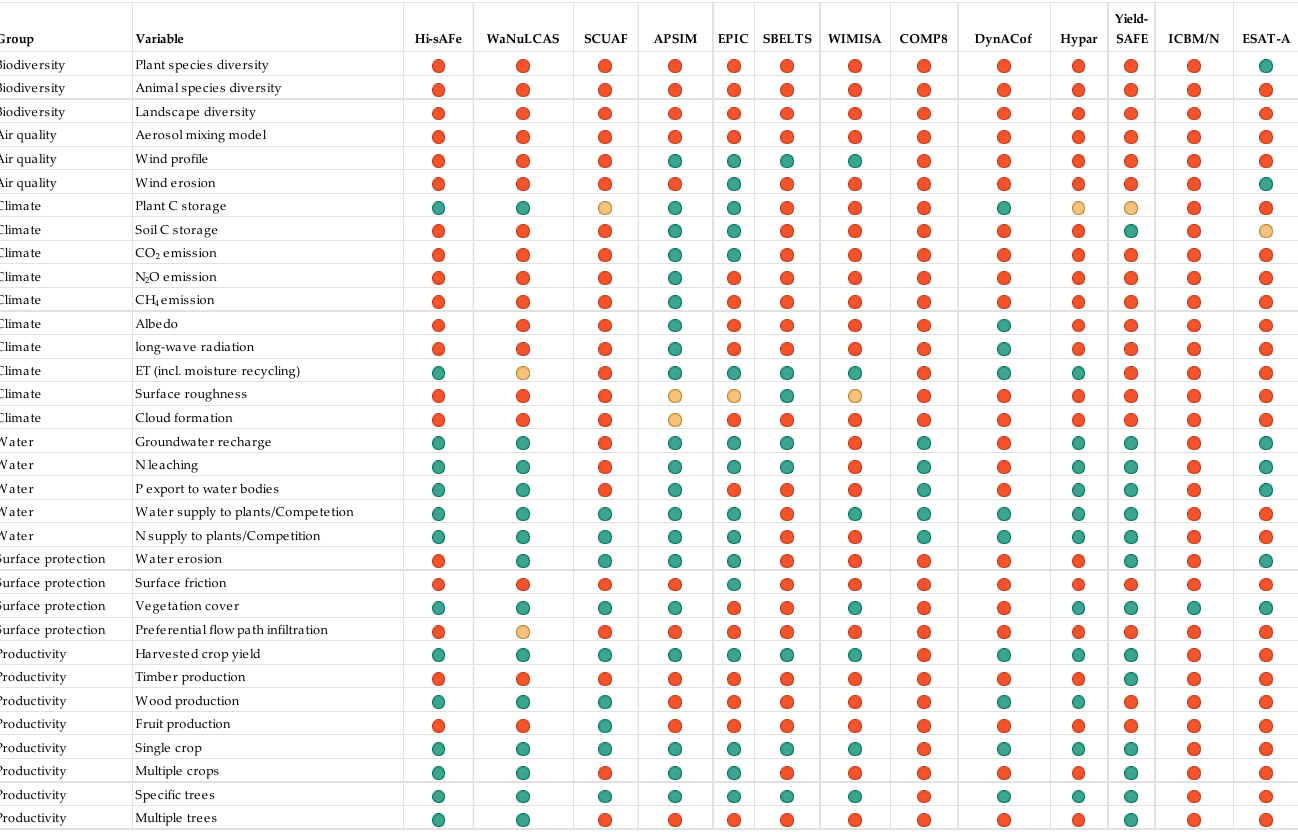
Figure A1. The same content of Table A1, with different presentation